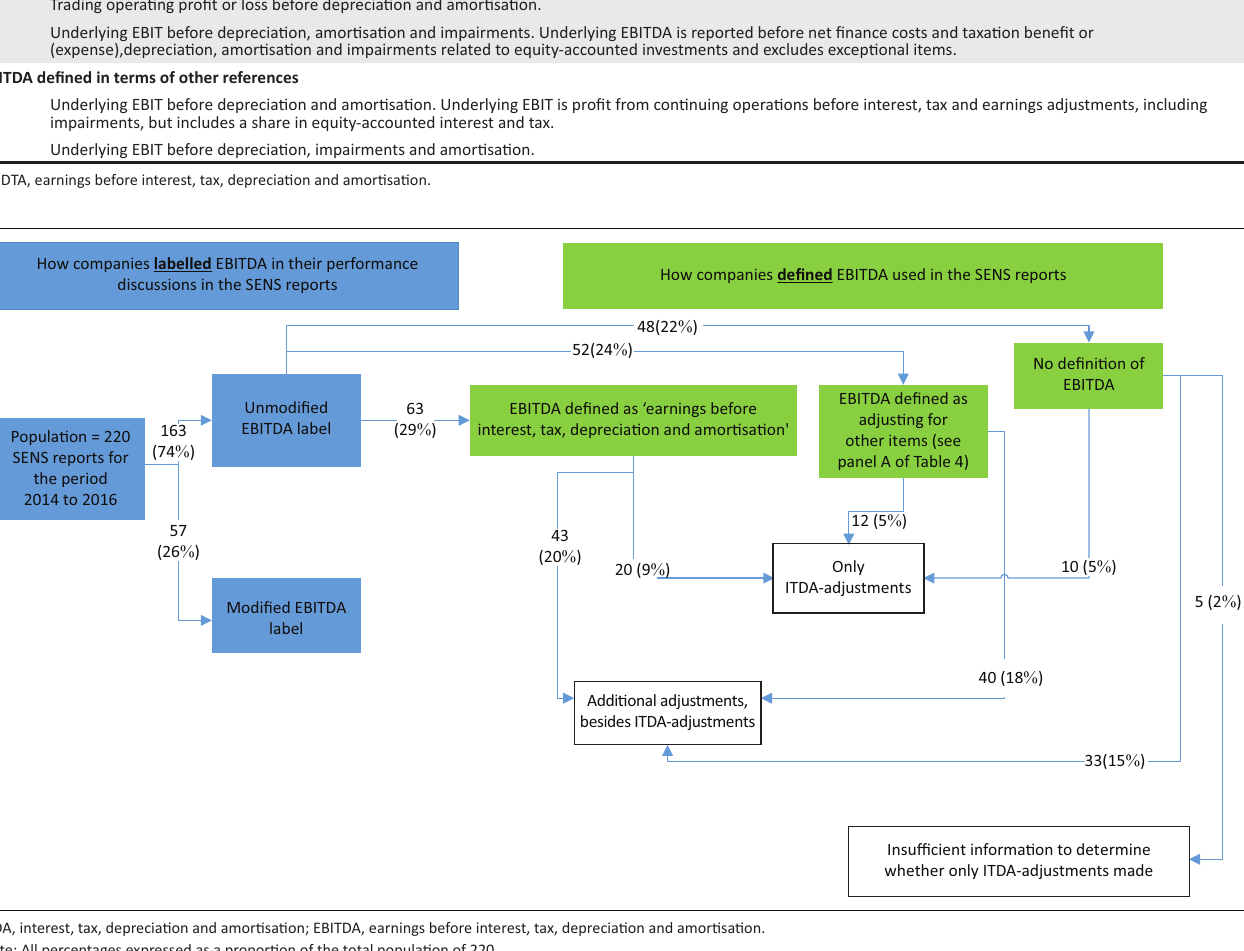
TABLE 4b (Continues...): List of non-standard definitions of earnings before interest, tax, depreciation and amortisation in Stock Exchange News Service reports from 2014 to 2016 ( N = 220). Number Panel B: Definitions of EBITDA as provided in the SENS reports in which a modified EBITDA label was